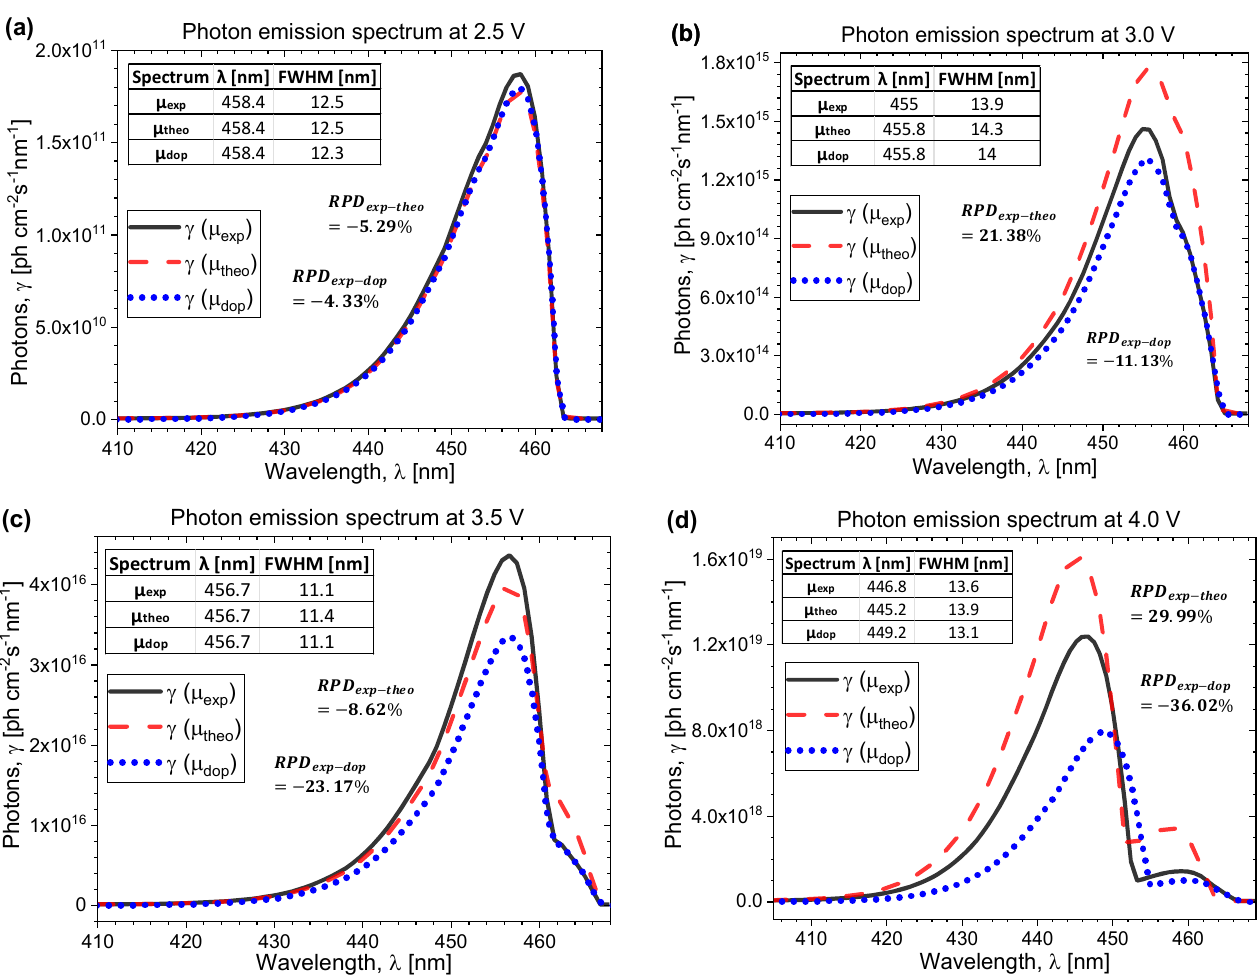
Figure 10. Photon emission spectrum of the LED for: ( a ) 2.5 V, ( b ) 3.0 V, ( c ) 3.5 V and ( d ) 4.0 V. Figure 12 shows the peak wavelength achieved for each mobility with respect to the transitions between electron and hole states. Since the Schrödinger equation is solved for supplied voltage (2.5–4.0) V, where it is confirmed the stable point of the emission each voltage point, one different set of eigenvalues and eigenfunctions is obtained at each step. Therefore, photon emission depends on the energy difference between states and their